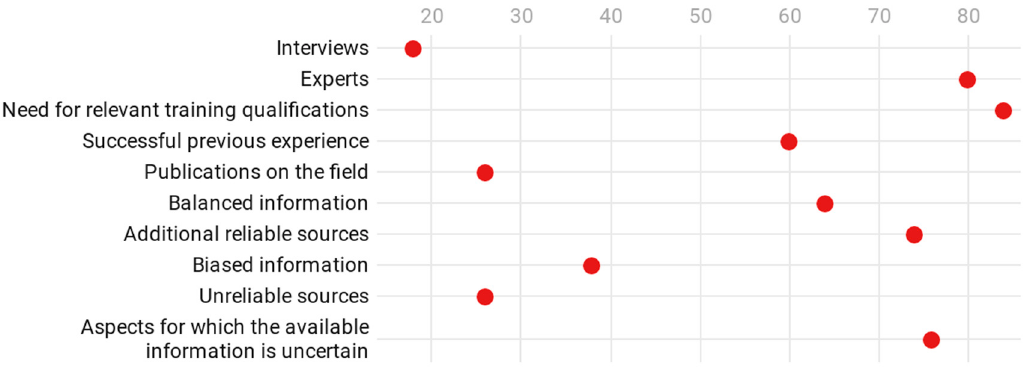
Figure 2. Information quality about the treatments.